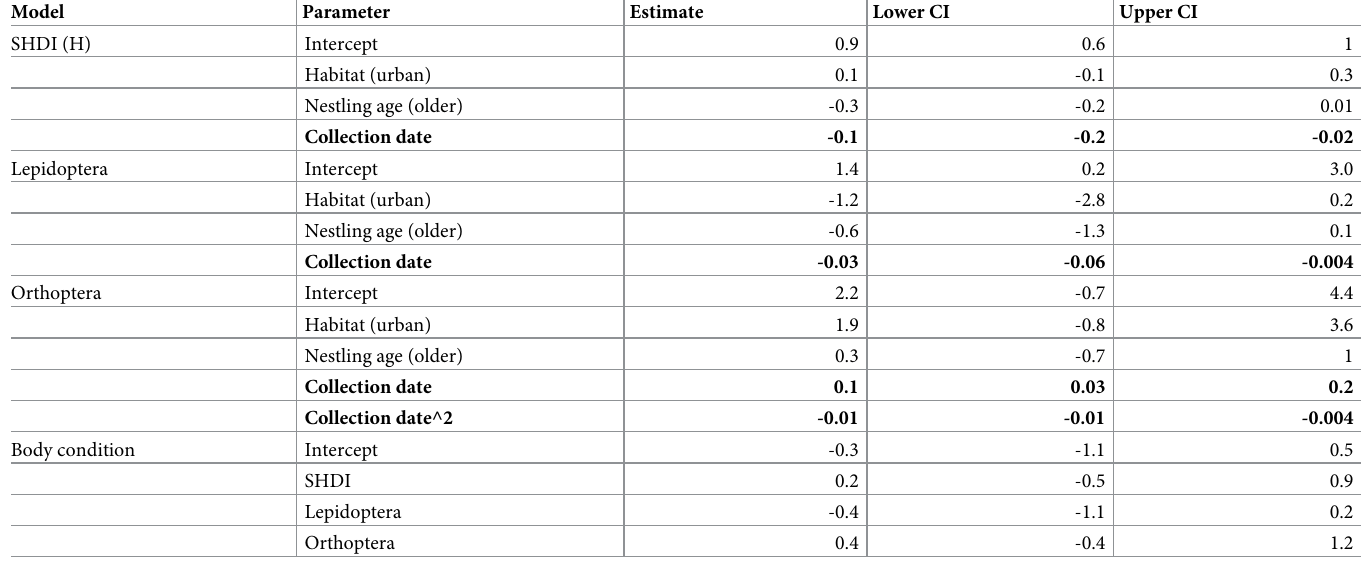
Table 2. Fixed effect coefficients and 95% confidence intervals from general linear mixed effects models testing whether diet diversity measured as Shannon diver- sity index (H), presence of Lepidoptera, and presence of Orthoptera vary by habitat, nestling age, or date and whether body condition varies by diet metrics. Model Parameter Estimate Lower CI Upper CI SHDI